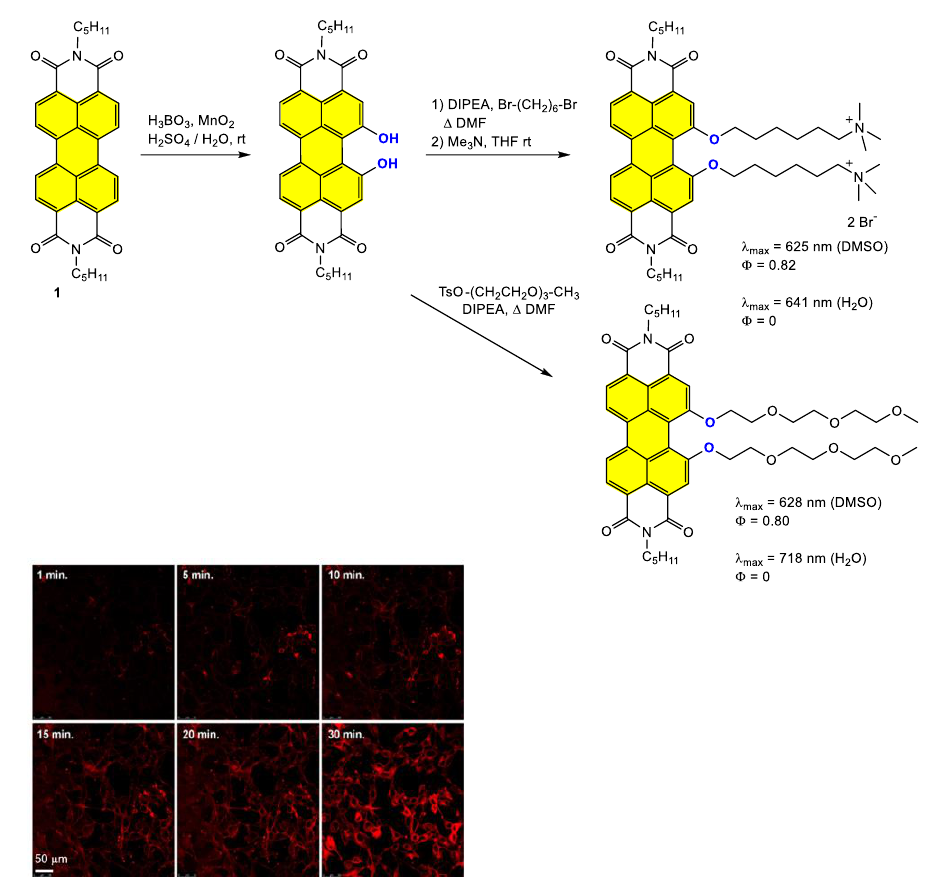
Figure 14. Synthesis of 1,12-dialkoxy PDI derivatives; confocal laser scanning microscopy images of HeLa cells in the first 30 min after administration of a 5 μM solution of PDI Gemini-type surfactant. Reprinted with permission from reference [119]. Copyright 2018 Wiley-VCH GmbH.